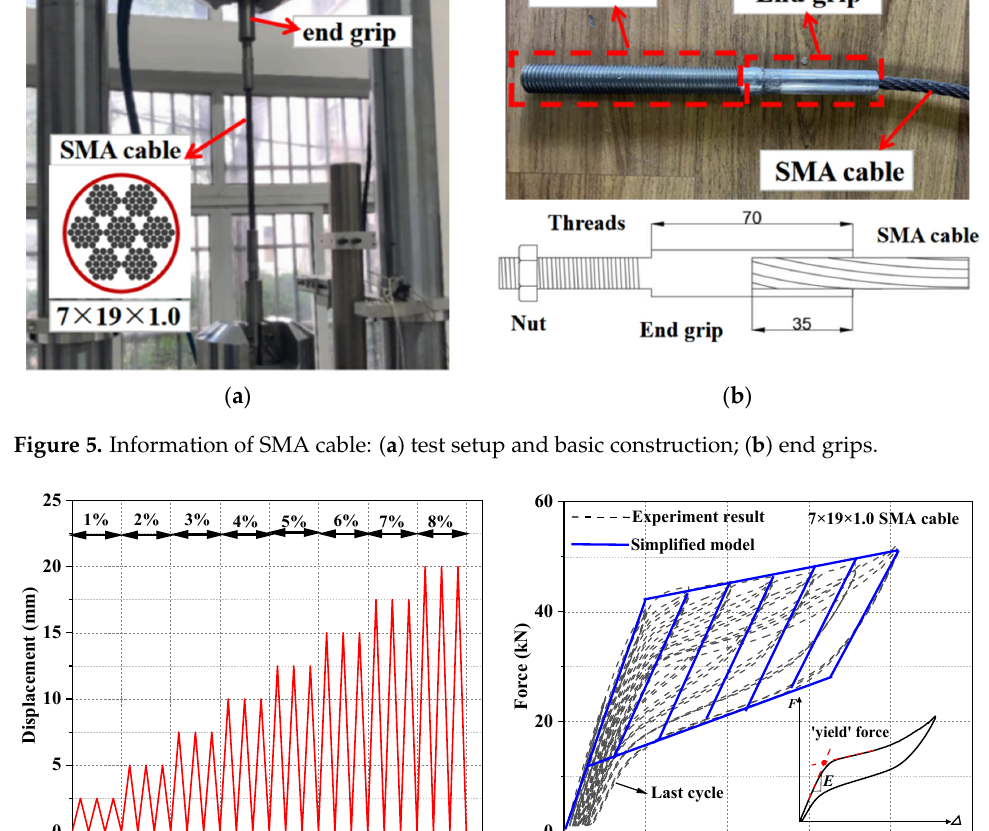
Figure 6. Test of SMA cable specimen: ( a ) loading protocol and ( b ) test results.